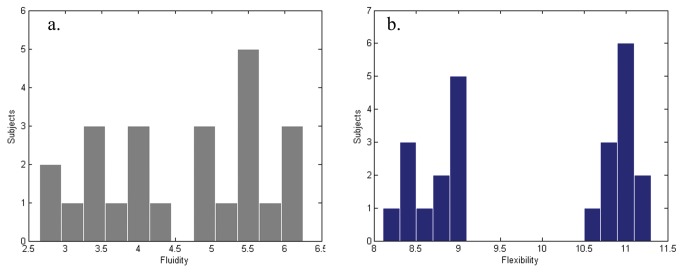
Scores distributions.Histogram of fluidity (left) and flexibility (right) scores obtained for all subjects during performance inside the scanner.